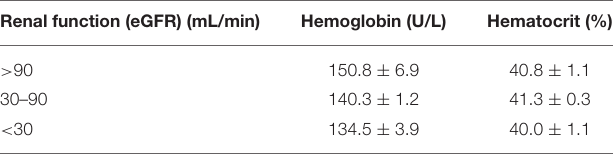
TABLE 3 | The relationship between anemia status and renal function. Renal function (eGFR)